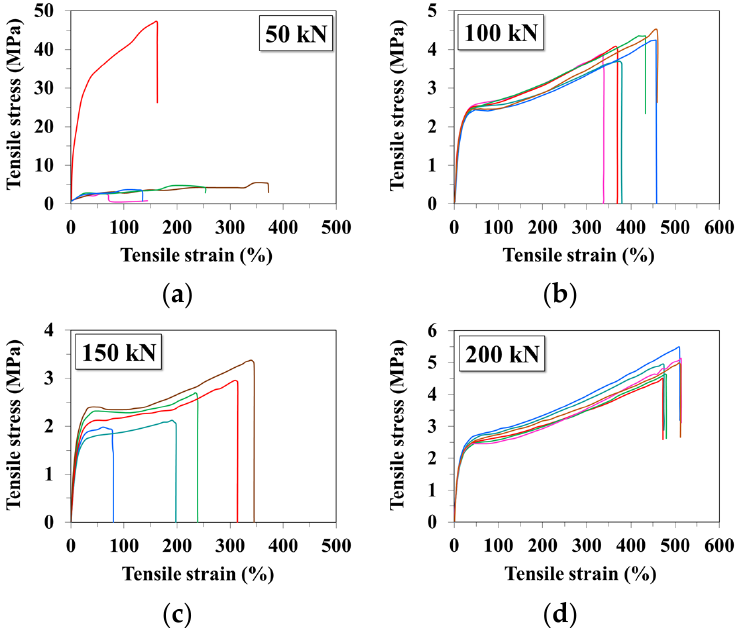
Figure 9. Dependence of the mechanical properties dispersion of the plates achieved from the selected ternary blends by the pressing pressure (a - 50 kN, b - 100 kN, c - 150 kN, d - 200 kN).